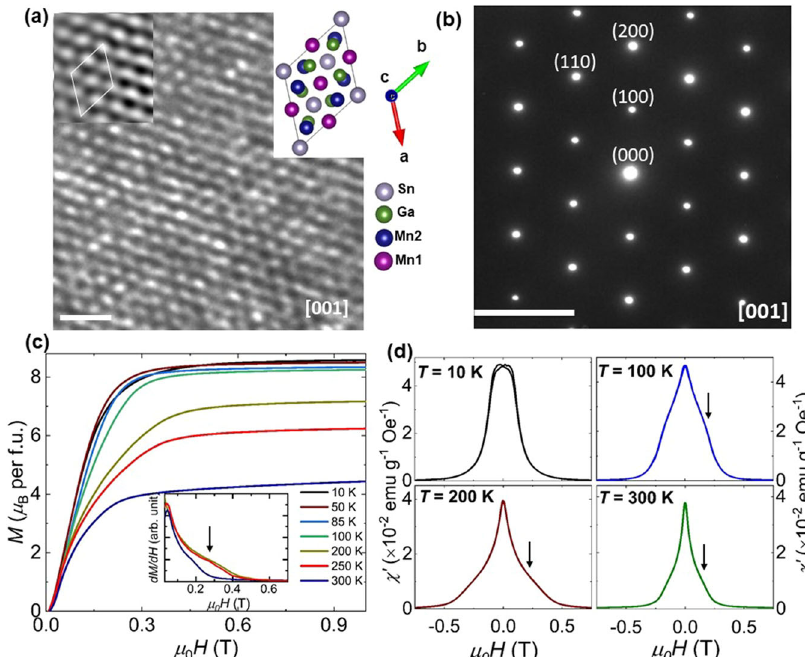
Fig. 2 Structural and magnetic properties of Mn 4 Ga 2 Sn. a High resolution transmission electron microscopy (HRTEM) image taken on [001] oriented sample plate. The insets show the enlarged view of the atomic arrangement reconstructed by using the inverse fast Fourier transformation (iFFT) of the fast Fourier transformed HRTEM image and the atomic unit cell of Mn 4 Ga 2 Sn viewed from the c-axis. The scale bar shown in the fi gure represents 1 nm. b Room temperature selected area electron diffraction (SAED) pattern taken on the sample plate with [001] orientation. The scale bar shown in the fi gure represents 2 nm − 1 . c Isothermal magnetization curves, M ( H ), measured at different temperatures. The inset shows the fi rst derivative of M ( H ) curves at selected temperatures. d ac susceptibility ( χ 0 ) vs magnetic fi eld ( μ 0 H ) plots at different temperatures from 10 K to 300 K. The black arrows point to the anomalies corresponding to the magnetic